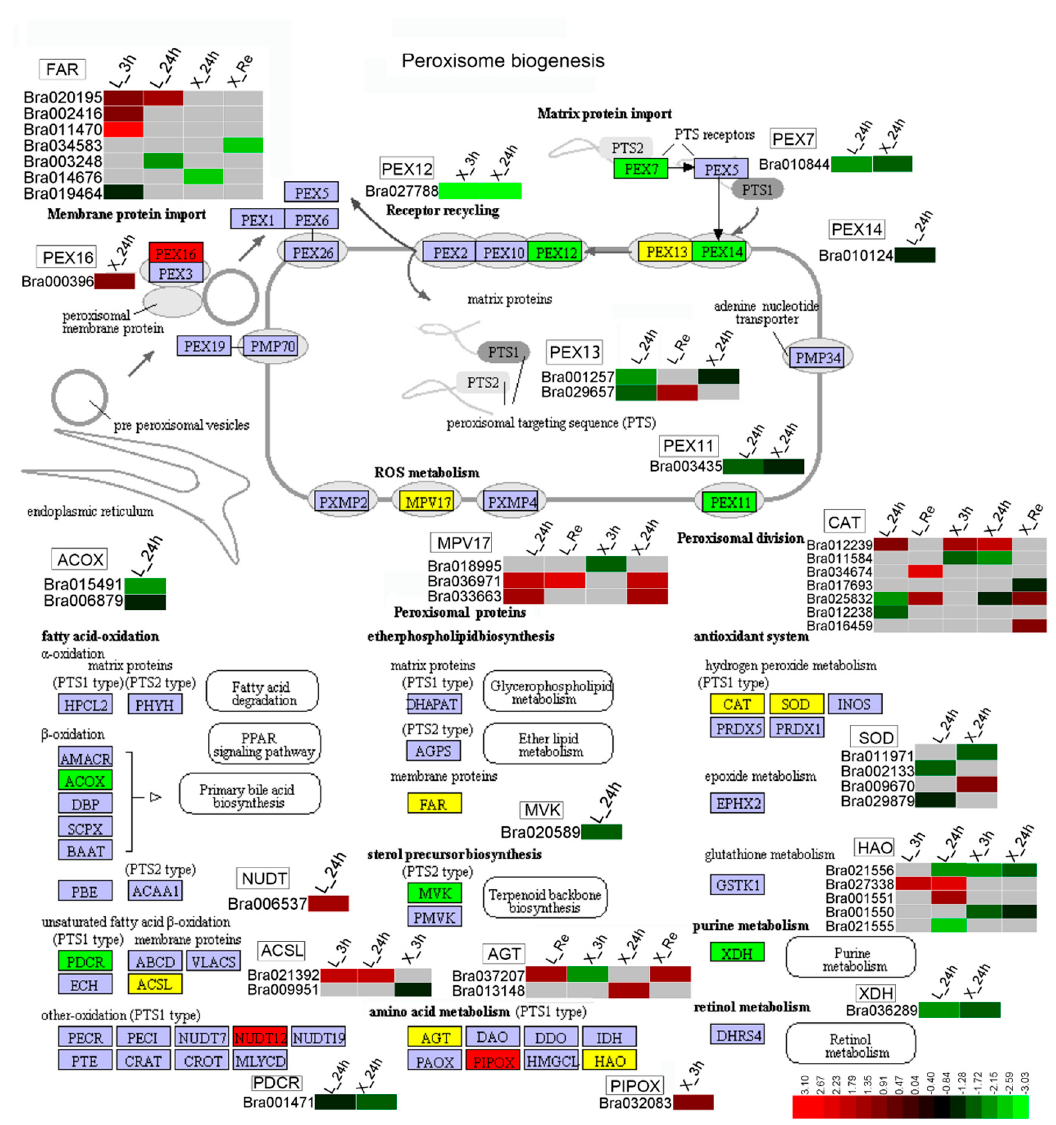
Figure 7. Cold-induced genes associated with the peroxisome pathway. Gene expression values were mapped to the reference pathway using KEGG. Red on the access map shows upregulated genes, green indicates downregulated genes, and yellow indicates genes that are both upregulated and downregulated. Gene annotations by KEGG in RNA-seq are represented in a heat map, where red indicates upregulated genes, green indicates downregulated genes, gray indicates no KEGG annotation, and DEGs for each pathway are marked next to the pathway map.